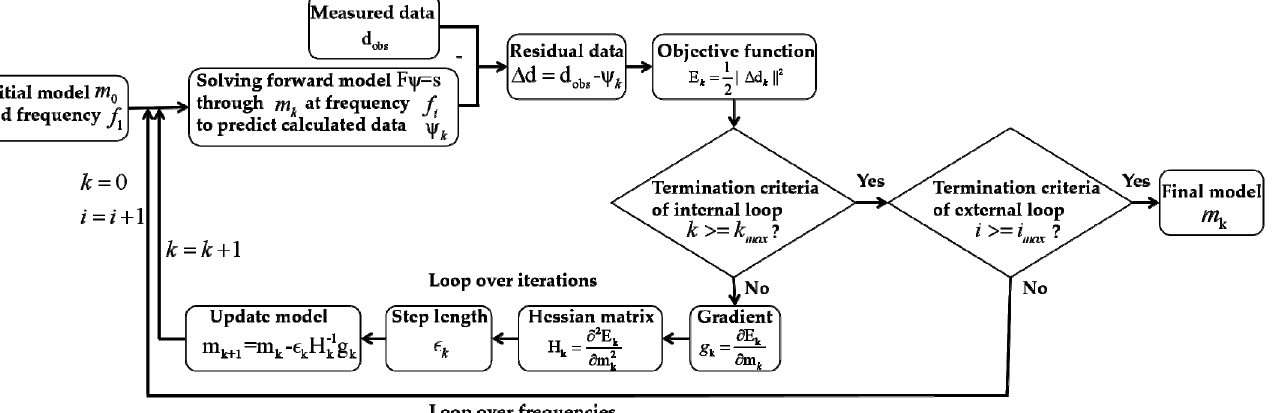
Figure 1. Workflow of the ultrasonic full waveform inversion